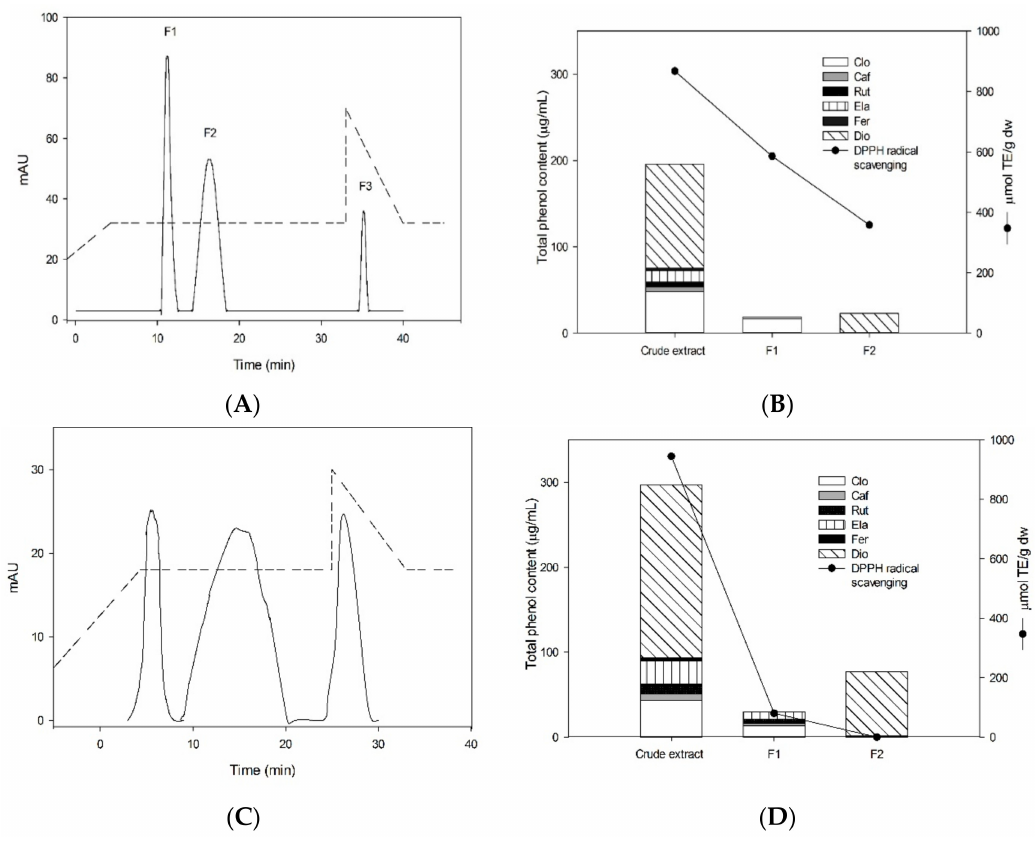
Figure 2. Modified chromatogram at 290 nm of UAE ( A ) and maceration ( C ) fractions separation obtained by an Isolera Prime System. Fractions polyphenolic profiles from UAE ( B ) and maceration ( D ) obtained by UPLC and Antioxidant activity expressed as µ mol TE/g dw of each fraction fixed at a concentration of 18 µ g/mL ( B ). Caf, caffeic acid; clo, chlorogenic acid; rut, rutin, ela, ellagic acid; fer, ferulic acid; dio,